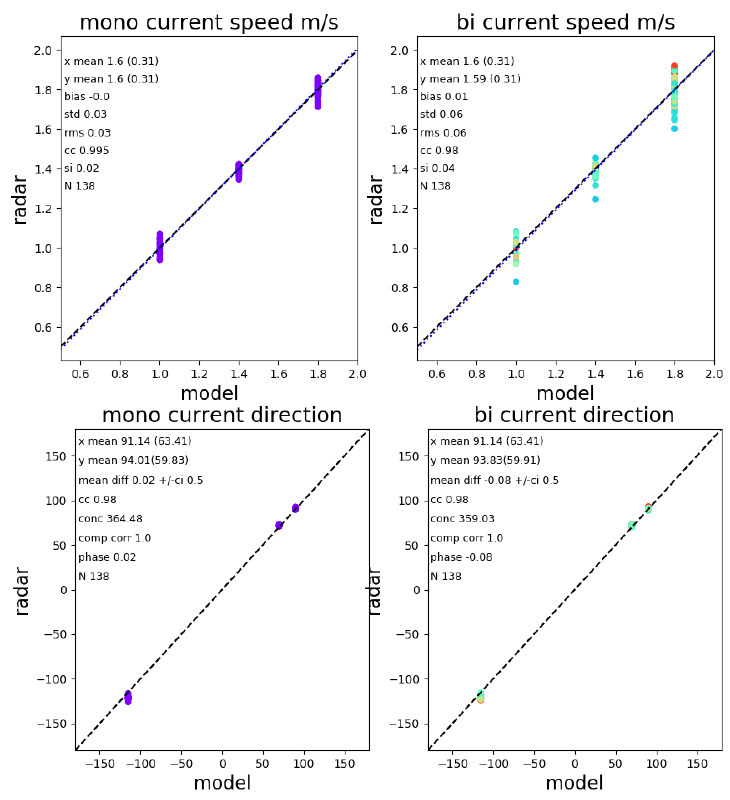
Figure 22. Scatter plots and statistics of the current measurements. These are colour-coded with the bistatic